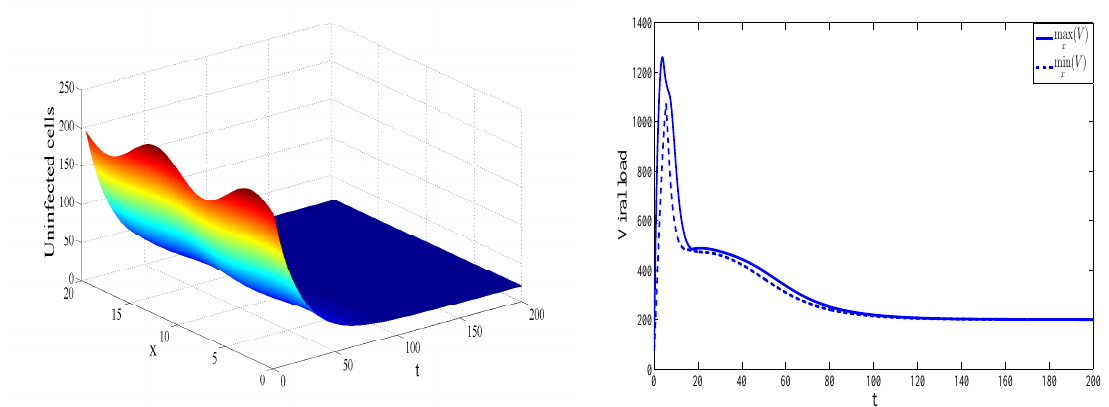
Figure 2. Dynamics of solution for λ = 1, d 1 = 0.0139, k 1 = 0.04, d 2 = 0.0495, k 2 = 1.1, d 3 = 0.5776 , a = 100, d 4 = 0.6, p = 0.0024, c = 0.15, and b = 0.5. The concentration of uninfected cells is shown as a function of x and t ( left ). The maximal and the minimal value of the virus concentration with respect to x are shown as functions of time ( right ).